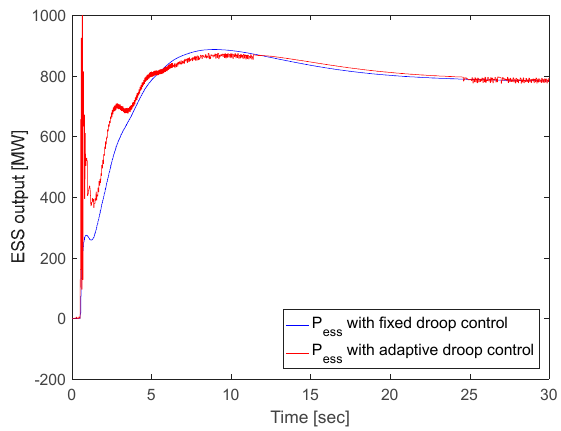
Figure 13 . ESS power output depending on droop control Figure 13. ESS power output depending on droop